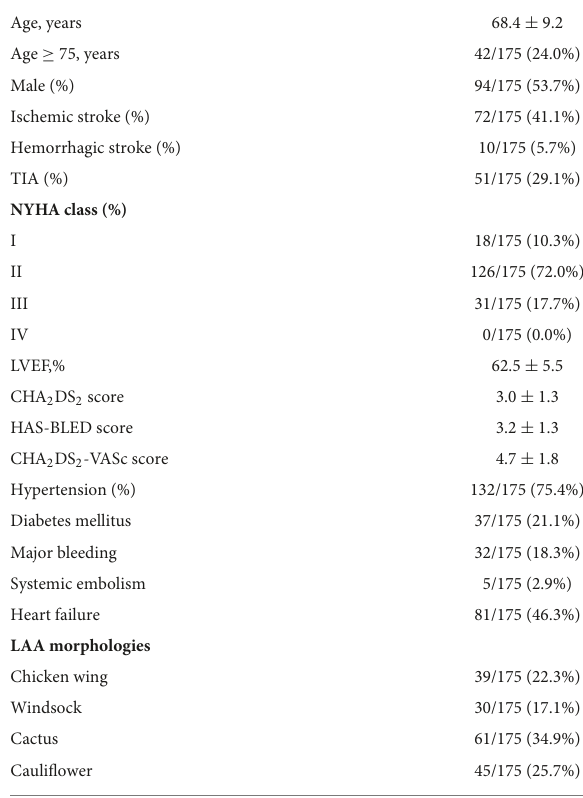
TABLE 1 Baseline demographic